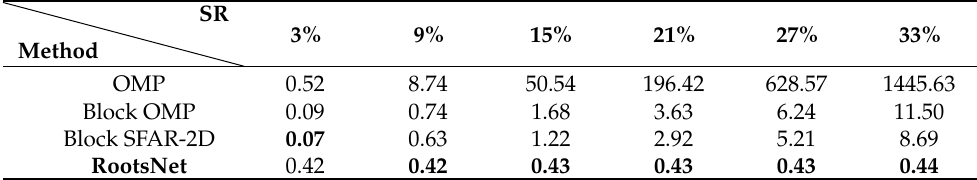
Table 1. CS reconstruction time (in seconds) for different methods.